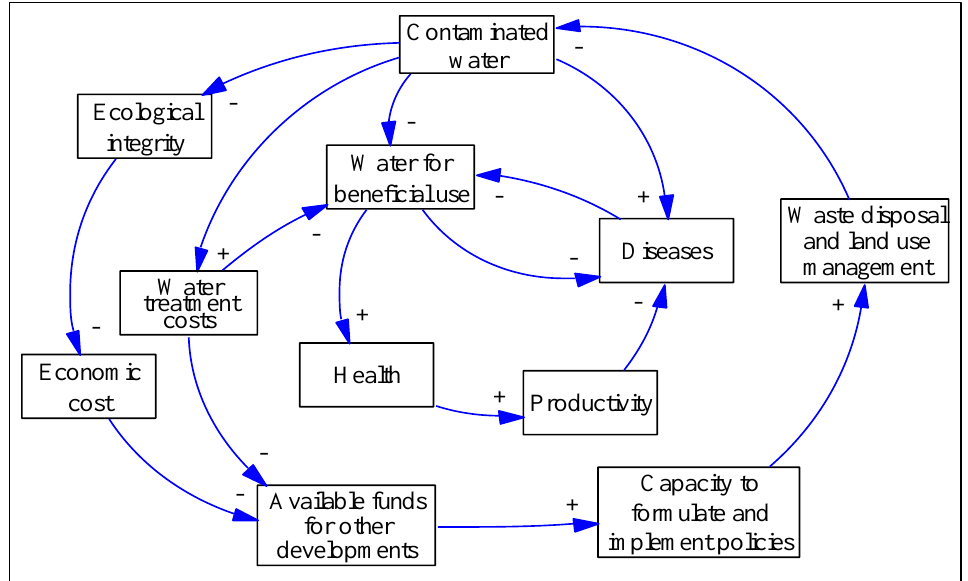
Figure 2: Causal loop on Environmental health and Economic